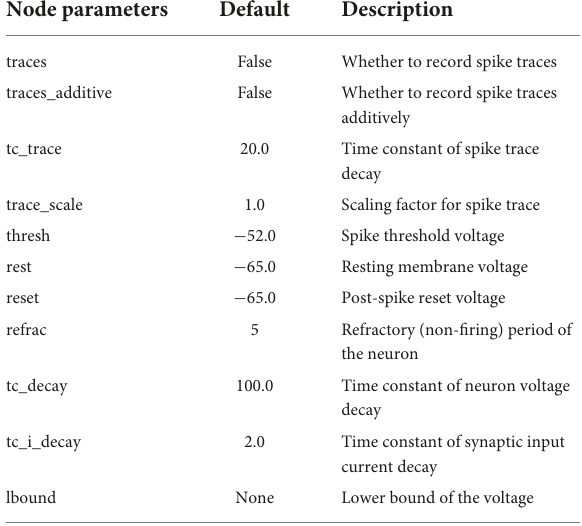
TABLE 1 Default parameters of current-based LIF